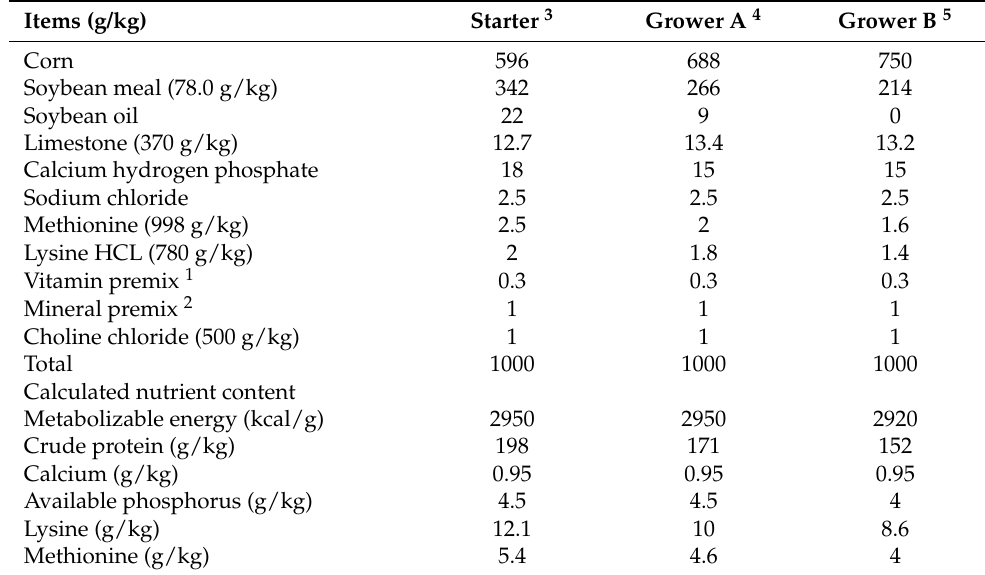
Table 3. Composition of basal diet used in the